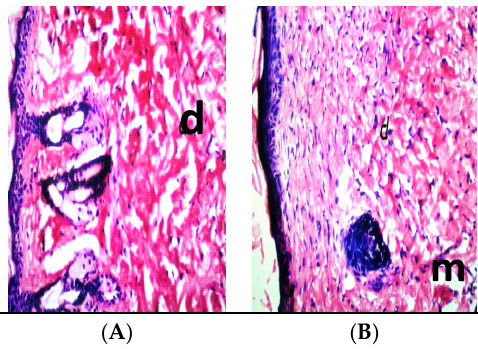
Figure 3. ( A , B ) Light micrograph (LM) of skin-infected mice at four weeks post-infection with 0.1 mL of 10 7 /mL promastigotes of Leishmania major , d: showing the intact histological structure of the epidermis and dermis, and a very large amount of inflammatory cell infiltration and fibroblastic proliferation in the subcutaneous layer (m).